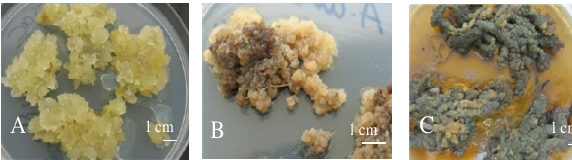
Fig. 4. Callus formation process. Callus formation began on the 7 th day of subcultering on wound areas and in medium containing sucrose (A) and glucose (D); The growth of callus on 15 th day in medium containing sucrose (B) and glucose (E); Grown callus in 30 th day in medium containing sucrose (C) and glucose (F)